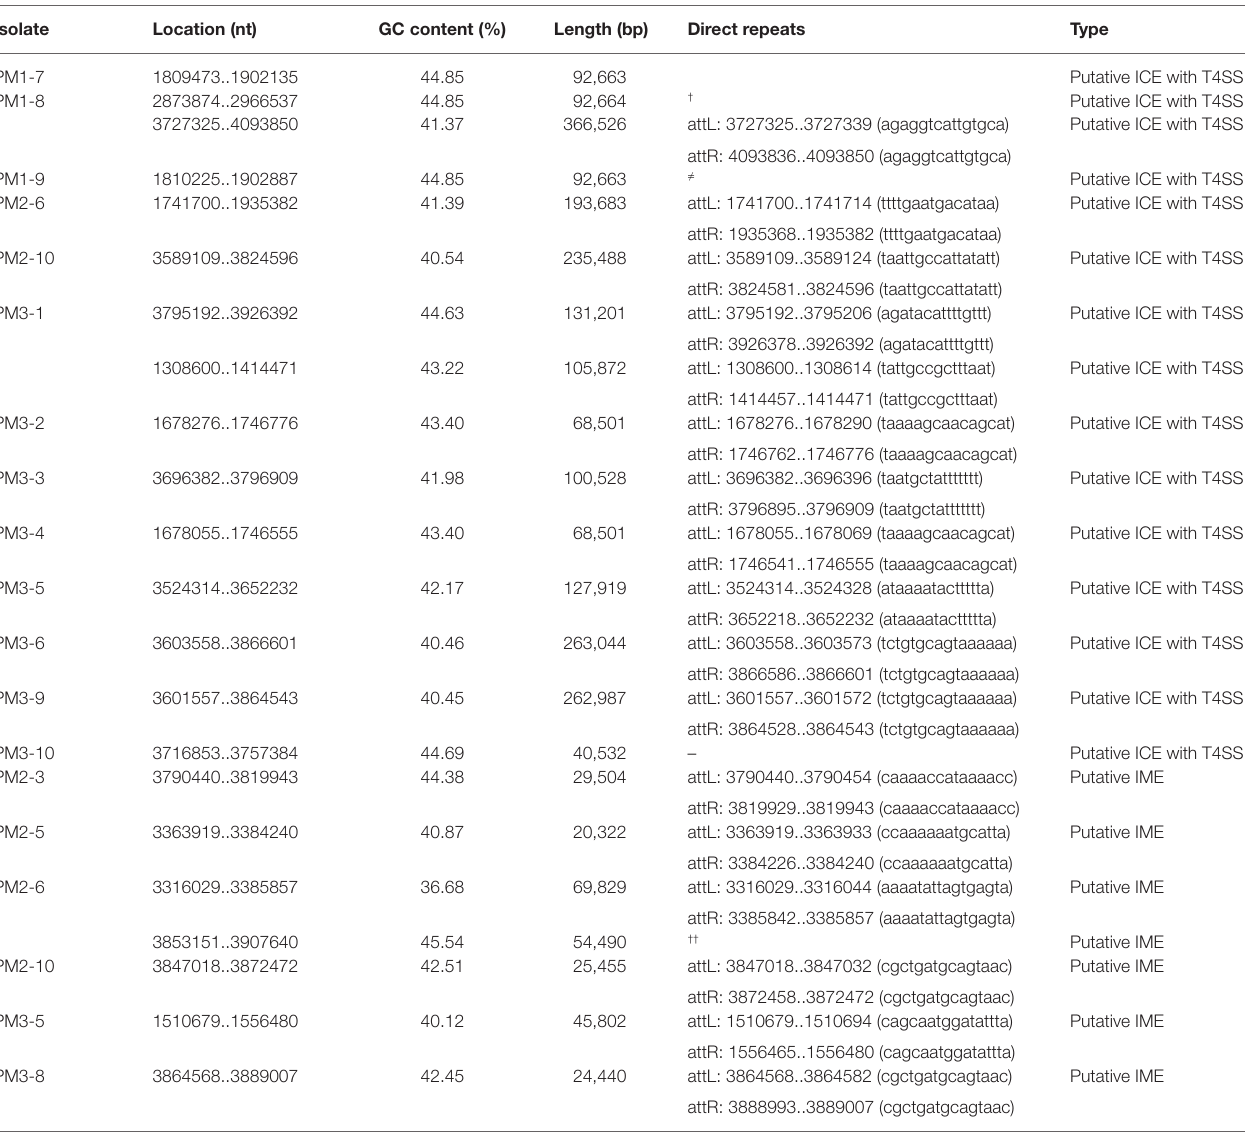
TABLE 5 | Details of 15 predicted ICEs and 7